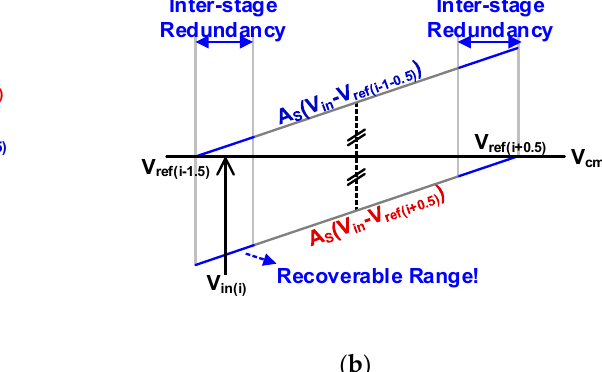
Figure 7. Non-idealities in the proposed architecture: ( a ) Schematic with the residue amplifier offset mismatch; ( b ) Resi- due profile. Figure 8. Proposed over-ranged residue generation technique: ( a ) Schematic for conceptual operation; ( b ) Residue pro- file with inter-stage redundancy.